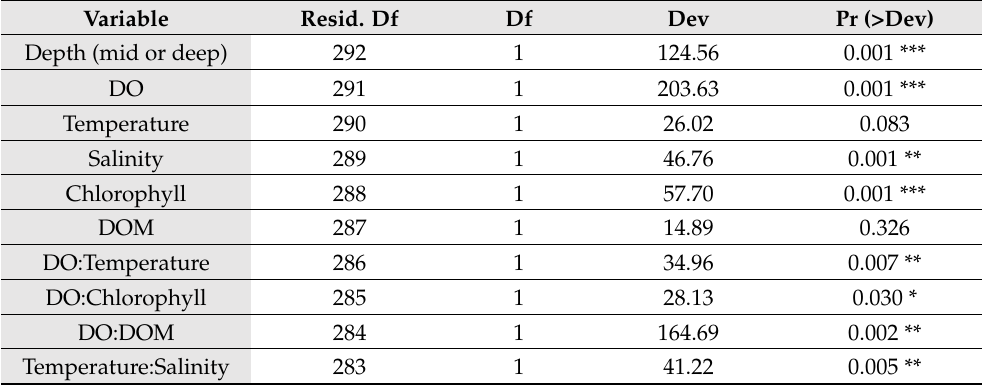
Table 2. Analysis of deviance table resulting from the GLM analysis on raw abundance data, assuming negative binomial distribution to account for overdispersion, fully factorial to the 2nd order. Model was subjected to stepwise removal of non-significant interactions. For each remaining term, we report the residual degrees of freedom (Resid. Df), degrees of freedom (Df), deviance (Dev), and p